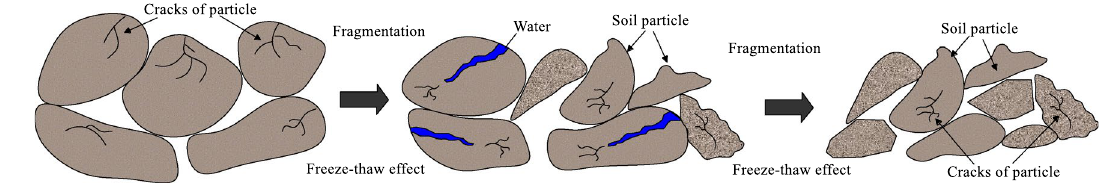
Figure 4. Conceptual diagram of the change in aspect ratio of large particle size due to freeze–thaw The dominant aspect ratio following higher amounts of freeze–thaw was 1.26, with over 12.43% of the four specimens showing an aspect ratio of 1.26 after 50 freeze–thaw cycles, and 11.22% after 100 freeze–thaw cycles, which indicates that the particles state is stable and not easily fragmented when the aspect ratio is 1.26. With the increase of freeze–thaw cycles, the percentage of particle aspect ratio increased or decreased, which indicated that the freeze–thaw cycles can change the particle’s aspect ratio. On the whole, the aspect ratio of particles shows a decreasing trend, that is, the proportion of particles with large aspect ratio decreases, and the proportion of particles with small aspect ratio increases, which indicates that the shape of particles is closer to circular or square with increasing freeze–thaw cycles. In order to better represent the change of aspect ratio of particles after freezing and thawing, the particle fragmenting process is described in the form of conceptual diagram. As shown in Fig. 4. The change process of particle aspect ratio is as follows: under the effect of temperature and tension, cracks are formed on the surface of soil particles. The water in the soil enters into the crack, and the phase change of water in the crack causes the crack to further develop and fragment. The fragmentation of the particles eventually leads to a change in the aspect ratio of the particles. It should be pointed out that the aspect ratio of the larger particle diameter may be smaller, and vice versa. The grain size of specimen (CS) after freeze–thaw cycles were used to analyze the change of particle aspect ratio. It can be seen from Fig. 5 that the aspect ratio of particles changed after freeze–thaw. The shape of particles is mainly polygonal, rectangular or elliptical, and the strip shape is very few, that is, the proportion of particles with larger aspect ratio is less, which indicates that particles with larger aspect ratio are easily fragmented. In addition, it was found that the proportion of particles with smaller aspect ratio was larger. This is consistent with the analysis results of specimen (CS) in Fig. 3.